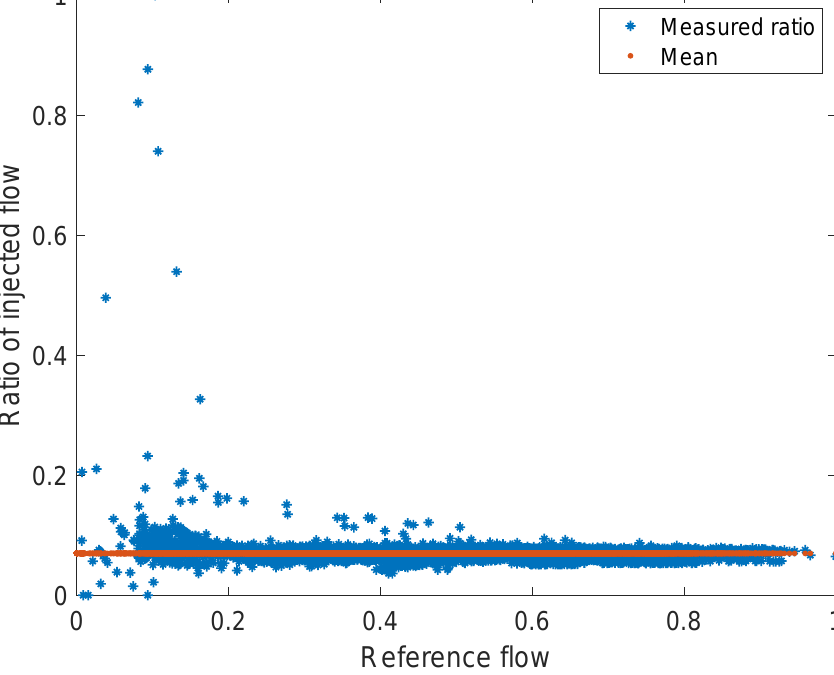
Figure 7. Flow ratio of an exemplary injection stream with respect to the stream the injection stream is injected to